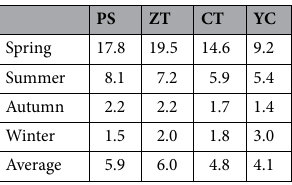
Table 10. Contribution of R s to R t in different seasons (unit: %).